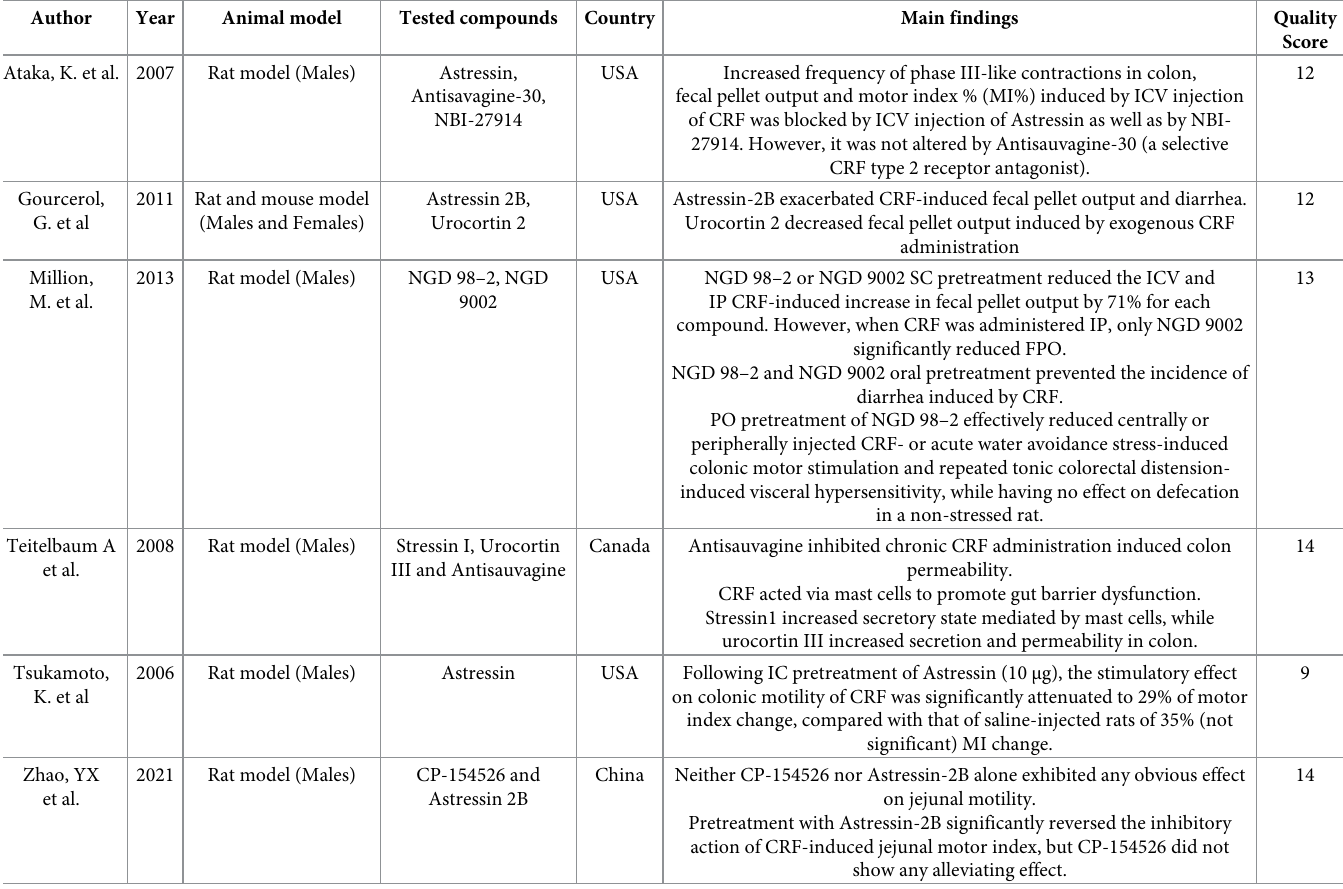
Table 1. CRF administration